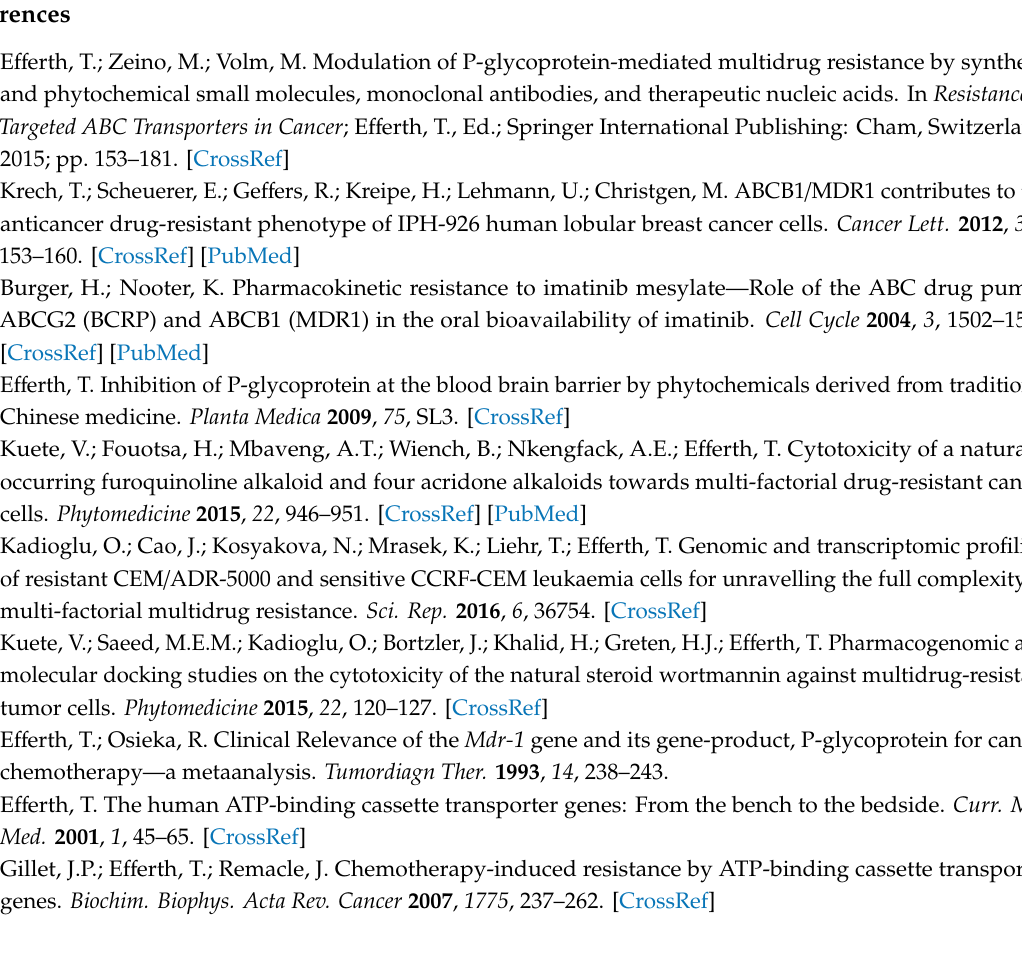
Table S1: Prediction of P-gp inhibitors identified by the random forest classification algorithm using the ChEMBL P-gp modulator list of 493 compounds, Table S2: Prediction of P-glycoprotein substrates identified by the RF classification algorithm using the ChEMBL P-gp modulator list of 150